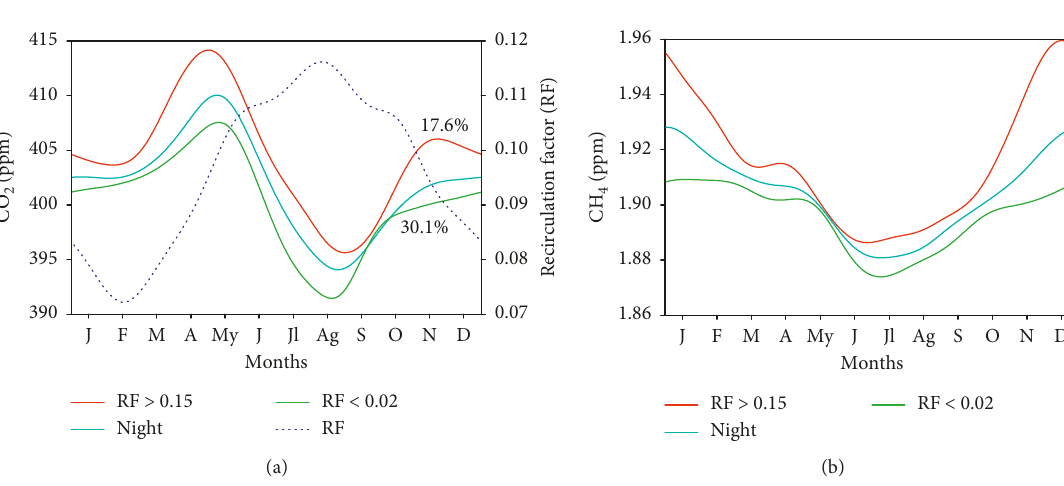
Figure 4: Annual evolution of the recirculation factor (RF) and CO 2 (a) and CH 4 (b) during the night. Three situations were considered: with all the observations (cyan line), for recirculation factors above 0.15 (red line), and for recirculation factors below 0.02 (green line). The appearance frequency for the low and high recirculation factor is also